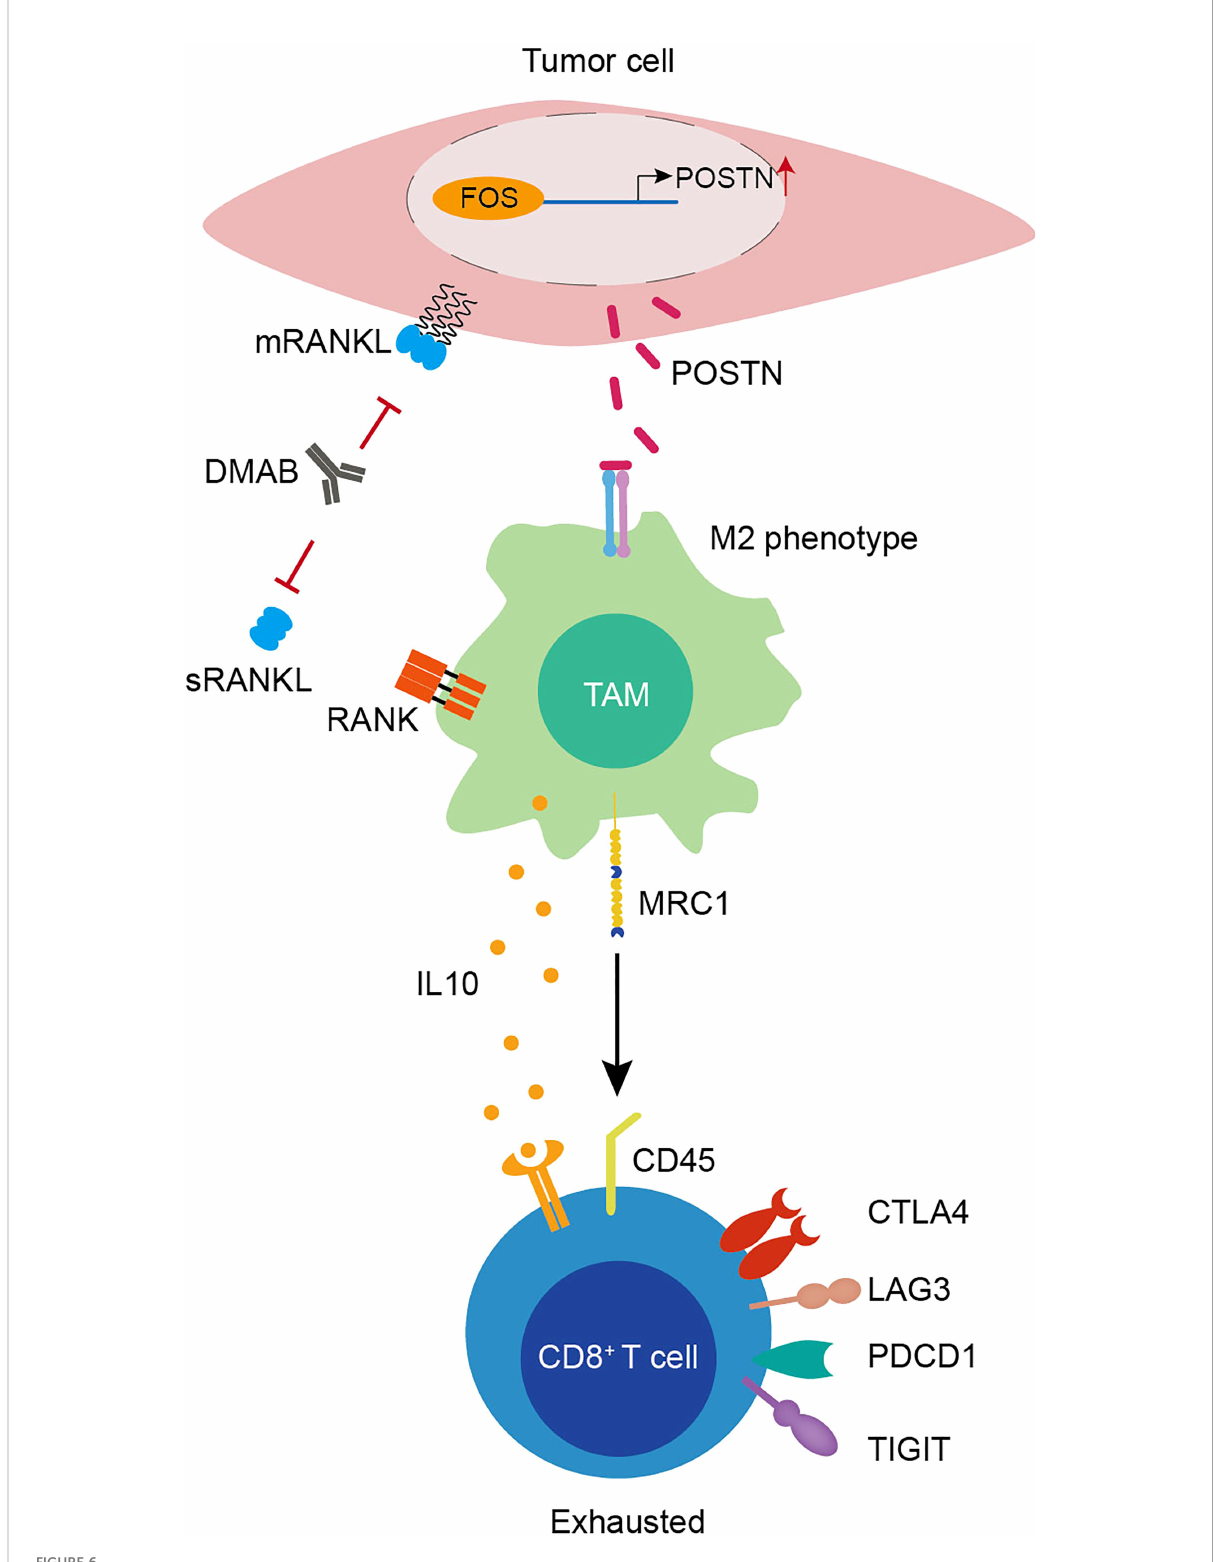
FIGURE 6 Graphical illustration of T-cell exhaustion in DMAB-treated GCTB based on bioinformatic